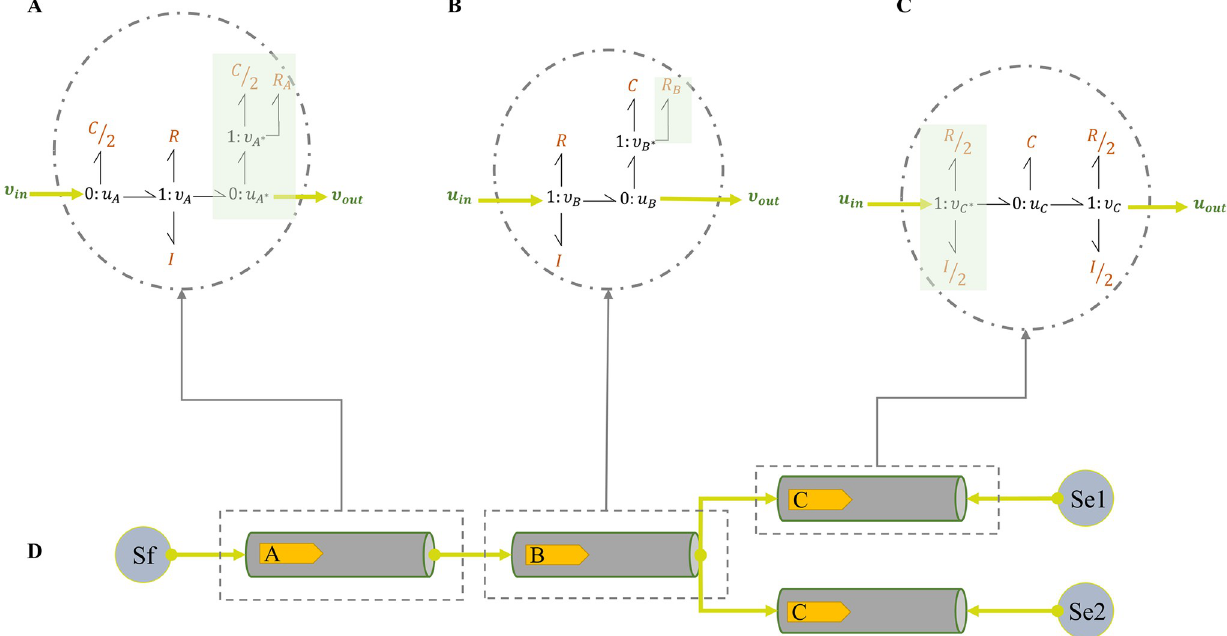
Fig 3. Required bond graph template modules for the vessels in the ADAN open-loop model. Depending on the type and location of a vessel, three template modules can be proposed: (A) initial segment; (B) intermediate segment; (C) terminal segment; (D) the schematic of the segments connections. S f and { Se 1 , Se 2 } are sources of flow and pressure in bond graphs which are cardiac output and venous pressure in the ADAN open-loop model [25]. The components in green boxes are the added sections to the original bond graph configuration of Fig 2.